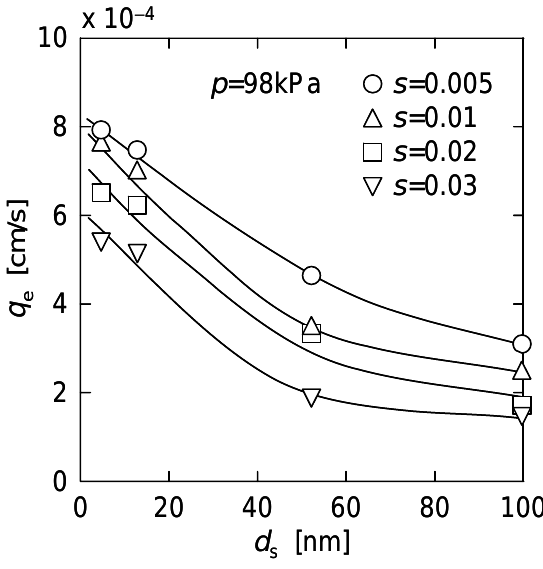
Figure 6. Effect of particle diameter on steady filtration rate.